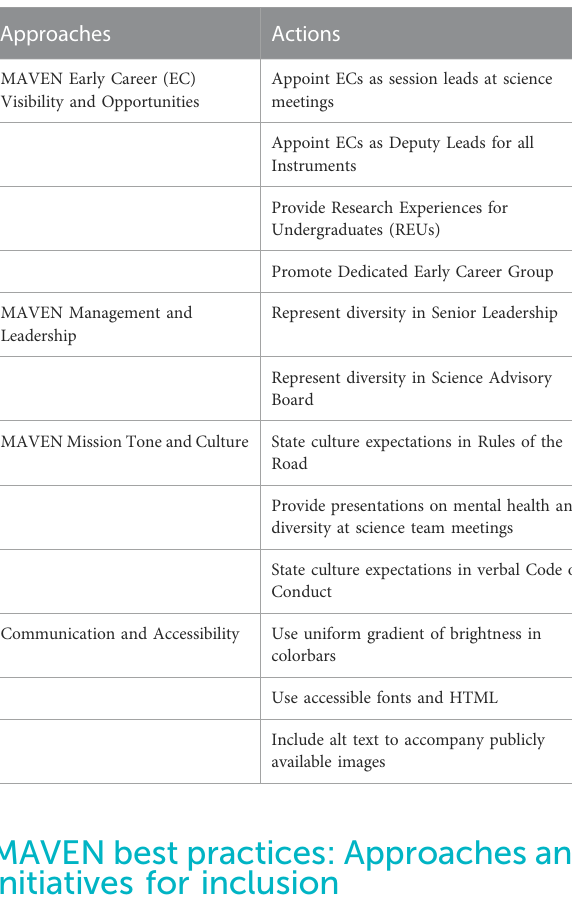
TABLE 1 MAVEN approaches for